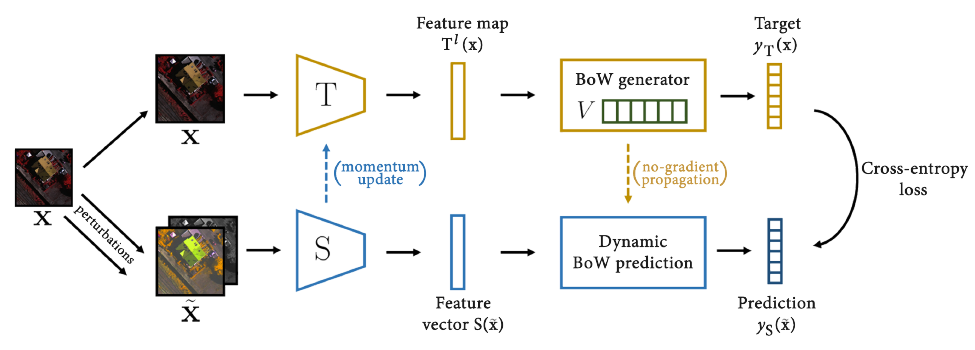
Figure 1. OBoW architecture.